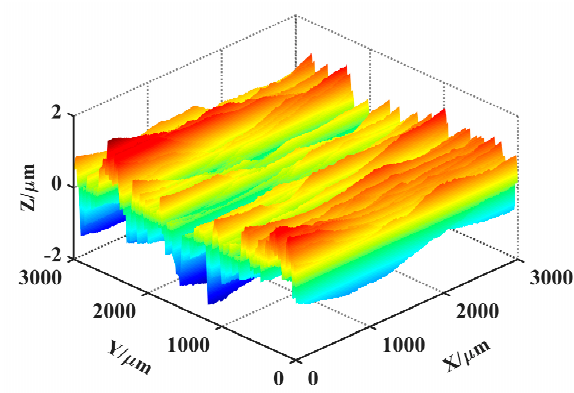
Figure 11. Simulation topography under v w = 5 m/s and a p = 5 µ m. To verify the accuracy of the simulation method, the roughness parameters of sim- ulation topography and measured topography under different machining parameters were compared. Due to limited space, only the simulation topography and measured topography under different feed speeds were selected for comparison. v w was 1 m/s, 5 m/s, 10 m/s and 15 m/s, respectively, and other machining parameters were the same as described in Section 3.1.